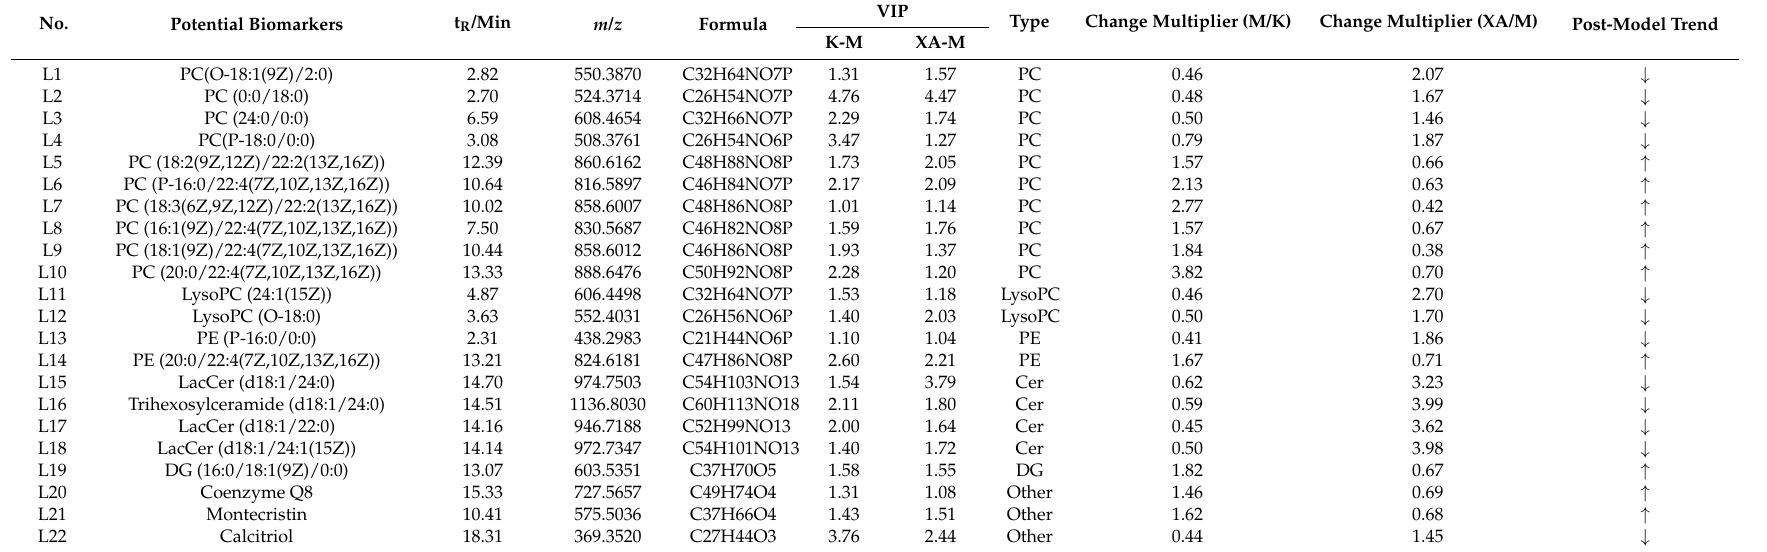
Table 7. Differentially expressed lipids in the control, model, and administration